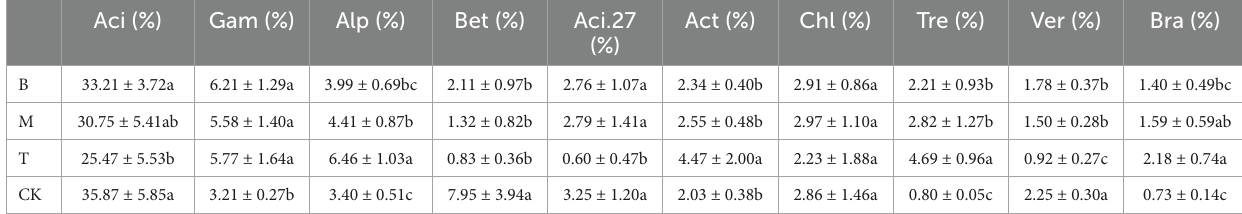
TABLE 2 The variation in relative abundance of the most abundant (top ten) microbial species in samples along the slope